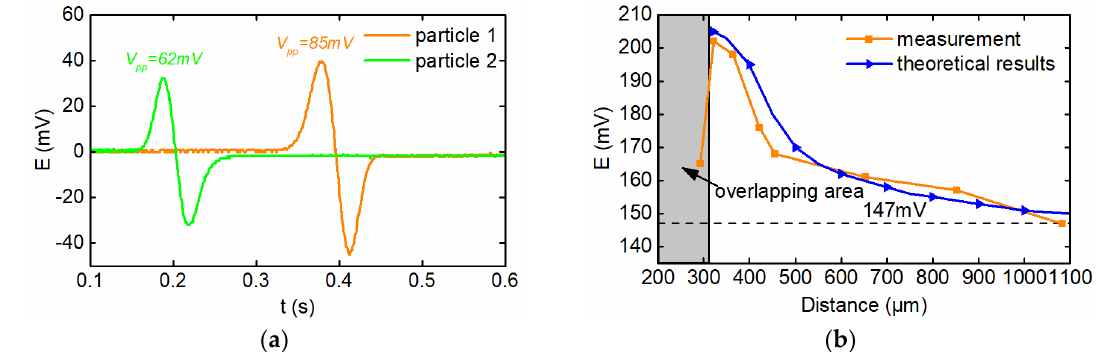
Figure 16. The signals. ( a ) The signal of single particle; ( b ) the signal of dual particle system.